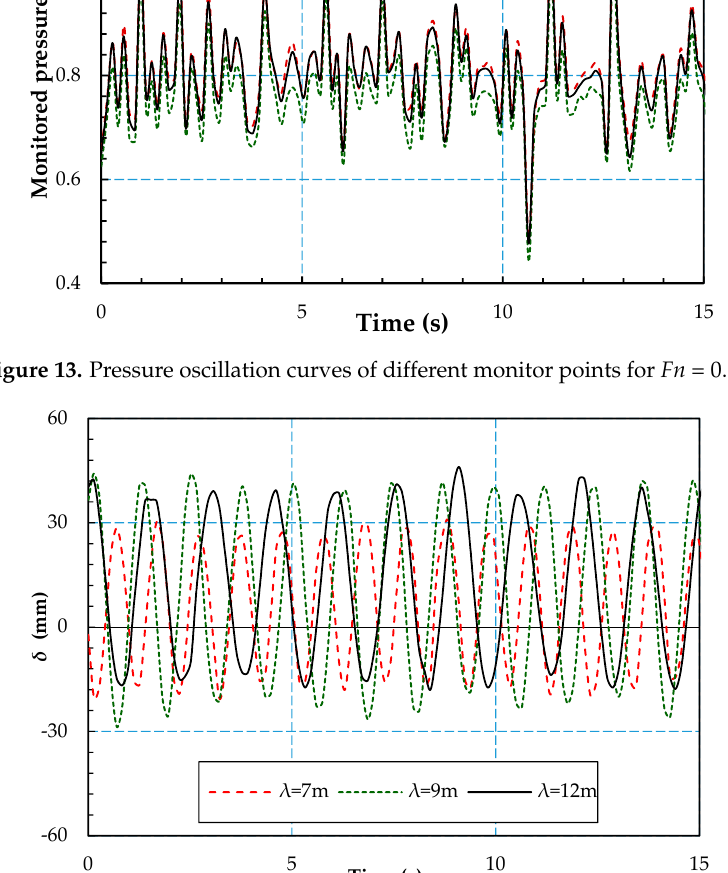
Figure 13. Pressure oscillation curves of different monitor points for Fn = 0.71.